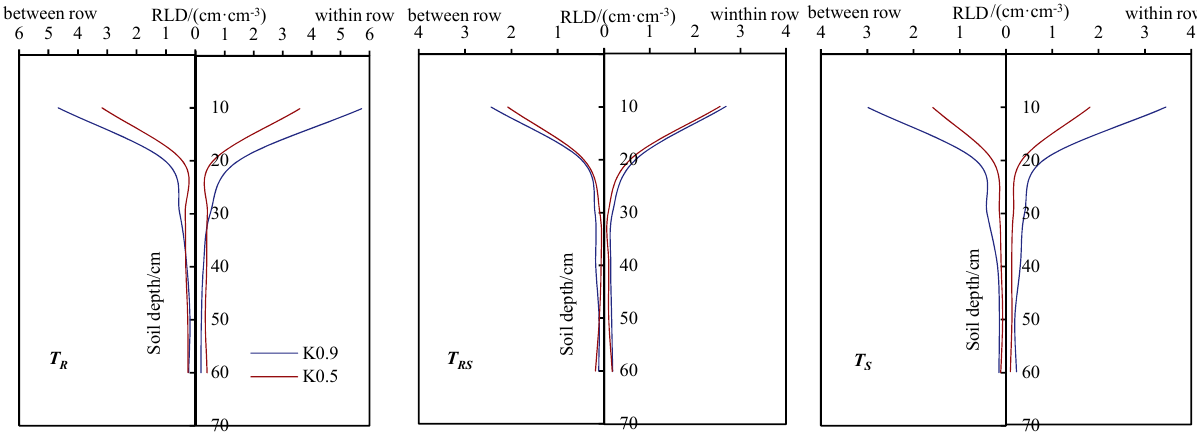
Figure 4. Tomato RLD distribution under different ventilation and irrigation amounts in 2021.